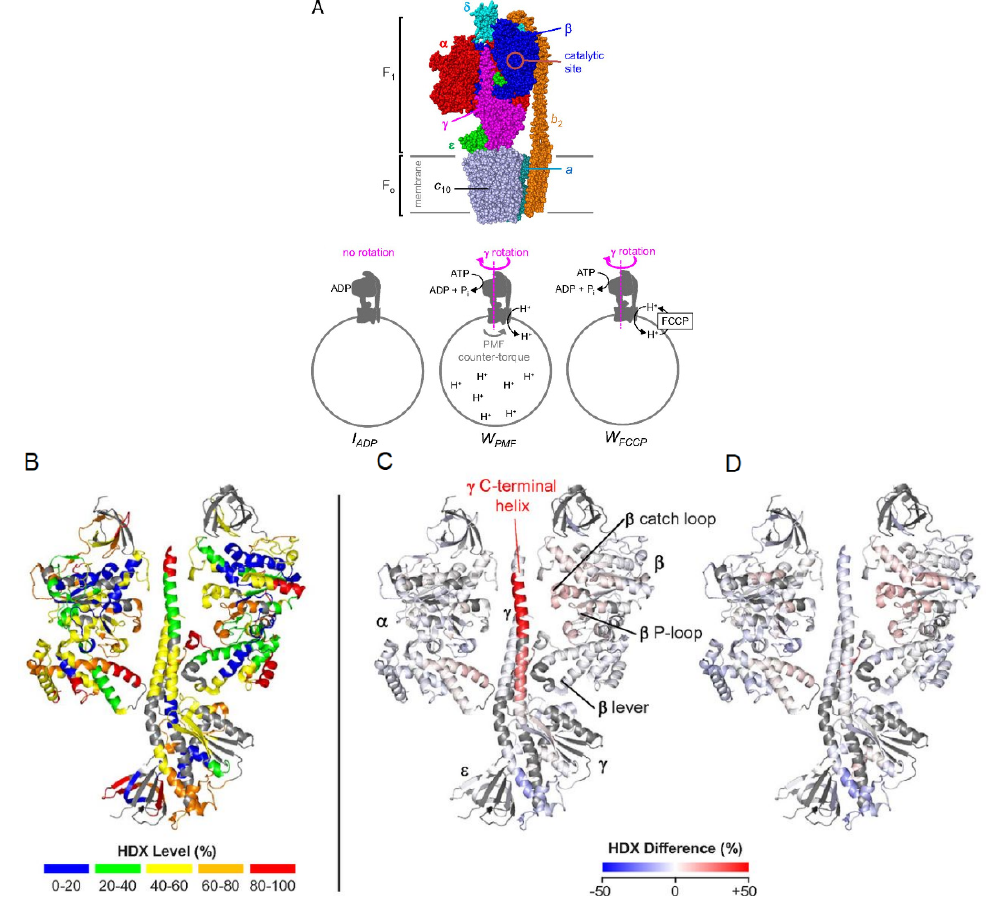
Figure 9. ( A ) Subunit architecture of F O F 1 ATP synthase from E. coli . The bottom panel depicts membrane vesicle-bound F O F 1 under different experimental conditions. ( B ) HDX levels of I ADP for an HDX period of 45 min. ( C ) Deuteration difference map of W PMF vs. I ADP . ( D ) Deuteration difference map of W FCCP vs. I ADP . Regions that were not covered are shown in dark gray. Colors represent deuteration percentages or HDX difference (%) as indicated in the legends. Reproduced with permission from the National Academy of Sciences (© 2016).